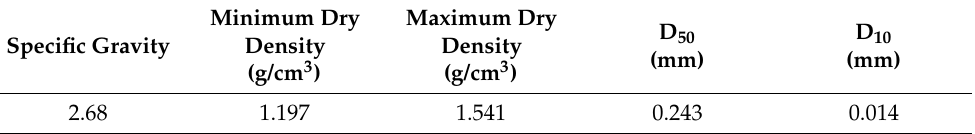
Table 1. The main physical parameters of silty-fine sand.